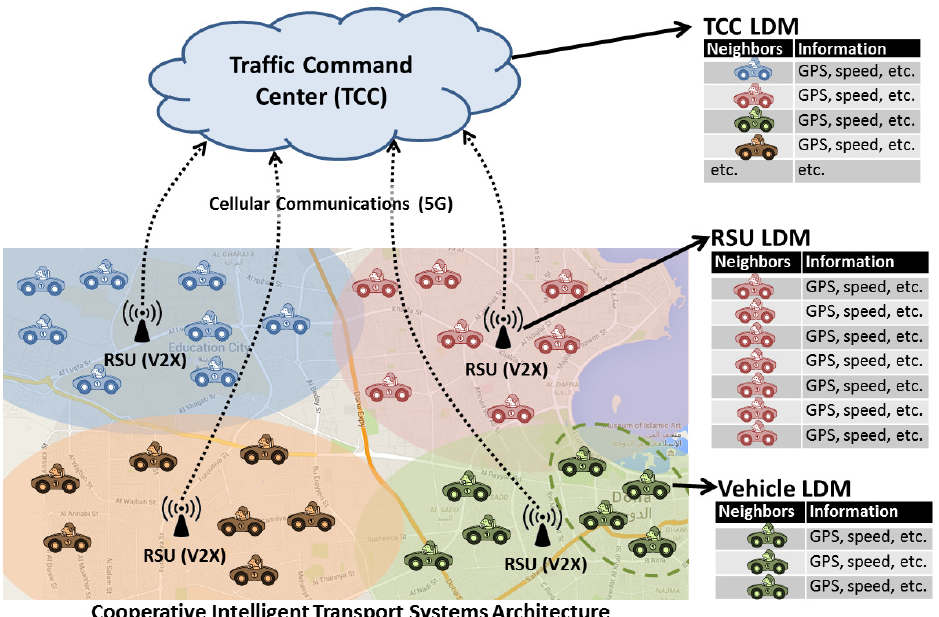
Figure 2. ITS based local dynamic